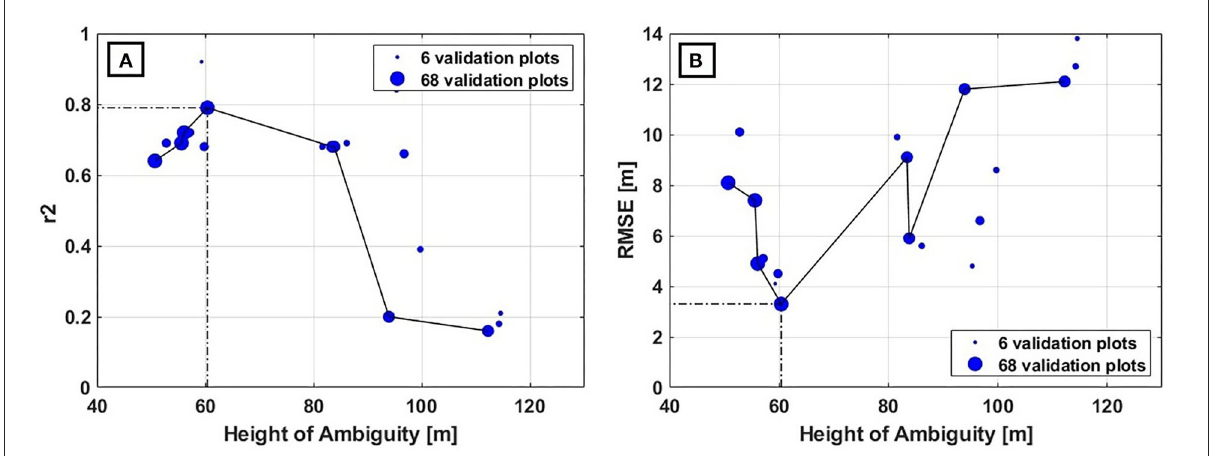
FIGURE4 Plot of inversion accuracy parameters against Height of Ambiguity. The size of the circles in the scatter plots are varied with respect to the number of validation plots covered by the particular acquisition. The smallest circle represents acquisition with 6 validations points and the largest circle denotes acquisition with 68 validations points. RMSE and r 2 of datasets with significant number of validation points are considered in order to see the trend. (A) RMSE Vs HoA. The point with dotted lines drawn to the axis denotes the optimum height that leads to least (best) RMSE. (B) r 2 Vs Height of ambiguity. The point with dotted lines drawn to the axes represents the optimum height that leads to highest (best) r 2